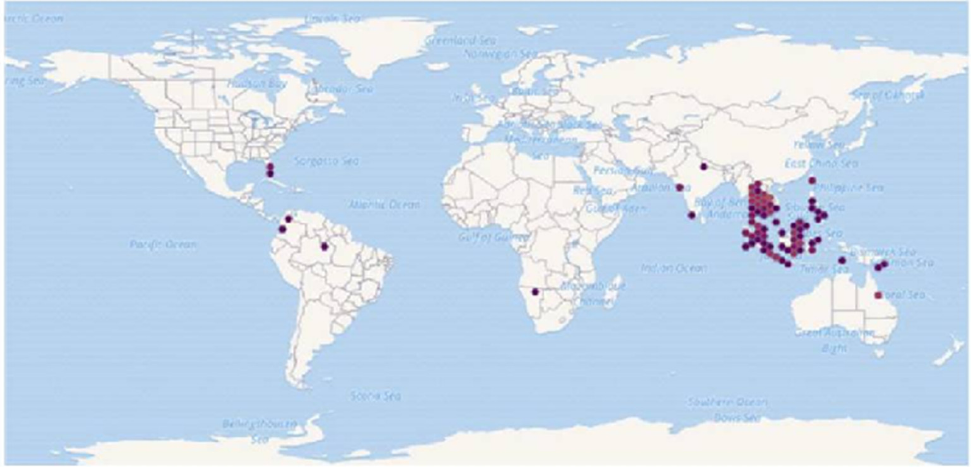
Figure 1. Known global distribution of Trichogaster trichopterus . Locations are in Australia, Papua- New Guinea, Indonesia, Malaysia, the Philippines, Taiwan, Vietnam, Cambodia, Laos, Thailand, Myanmar, India, Namibia, Colombia, Brazil, and the United States. Map from the GBIF Secretariat [11].